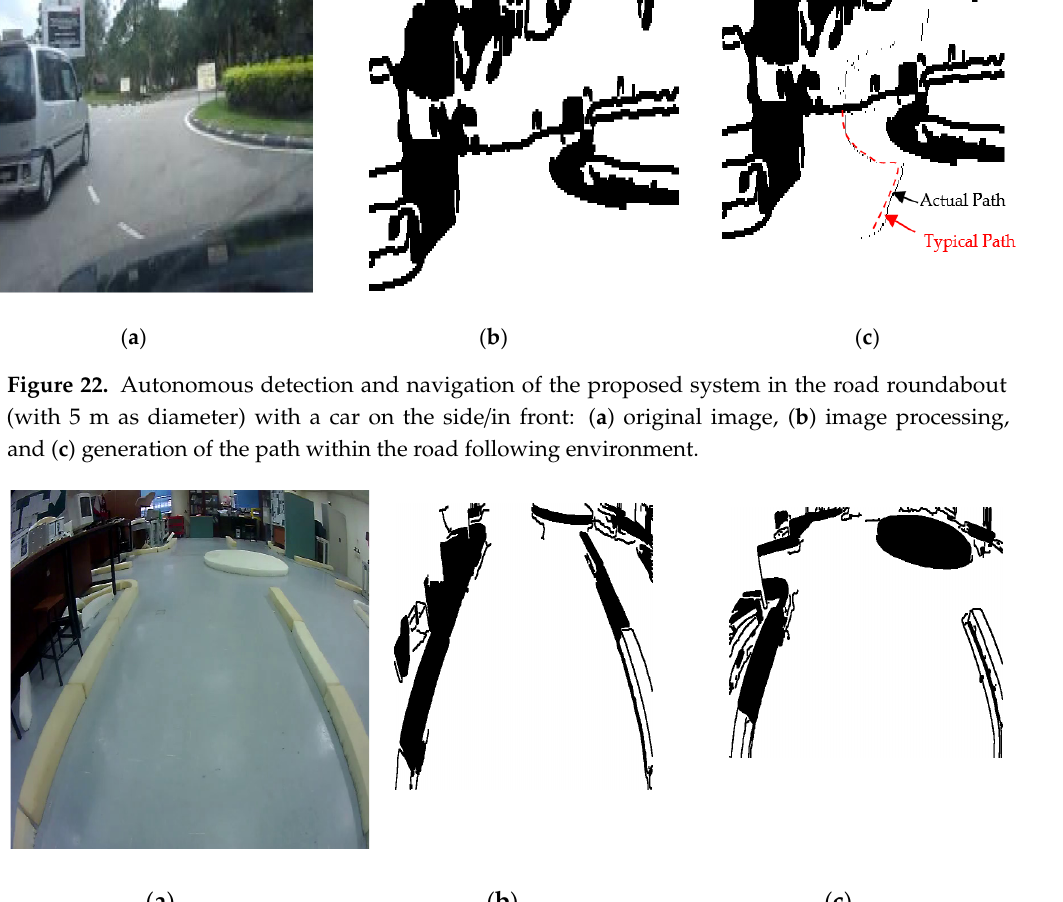
local map when the WMR starts to move, and ( c ) camera’s local map when the WMR detects the